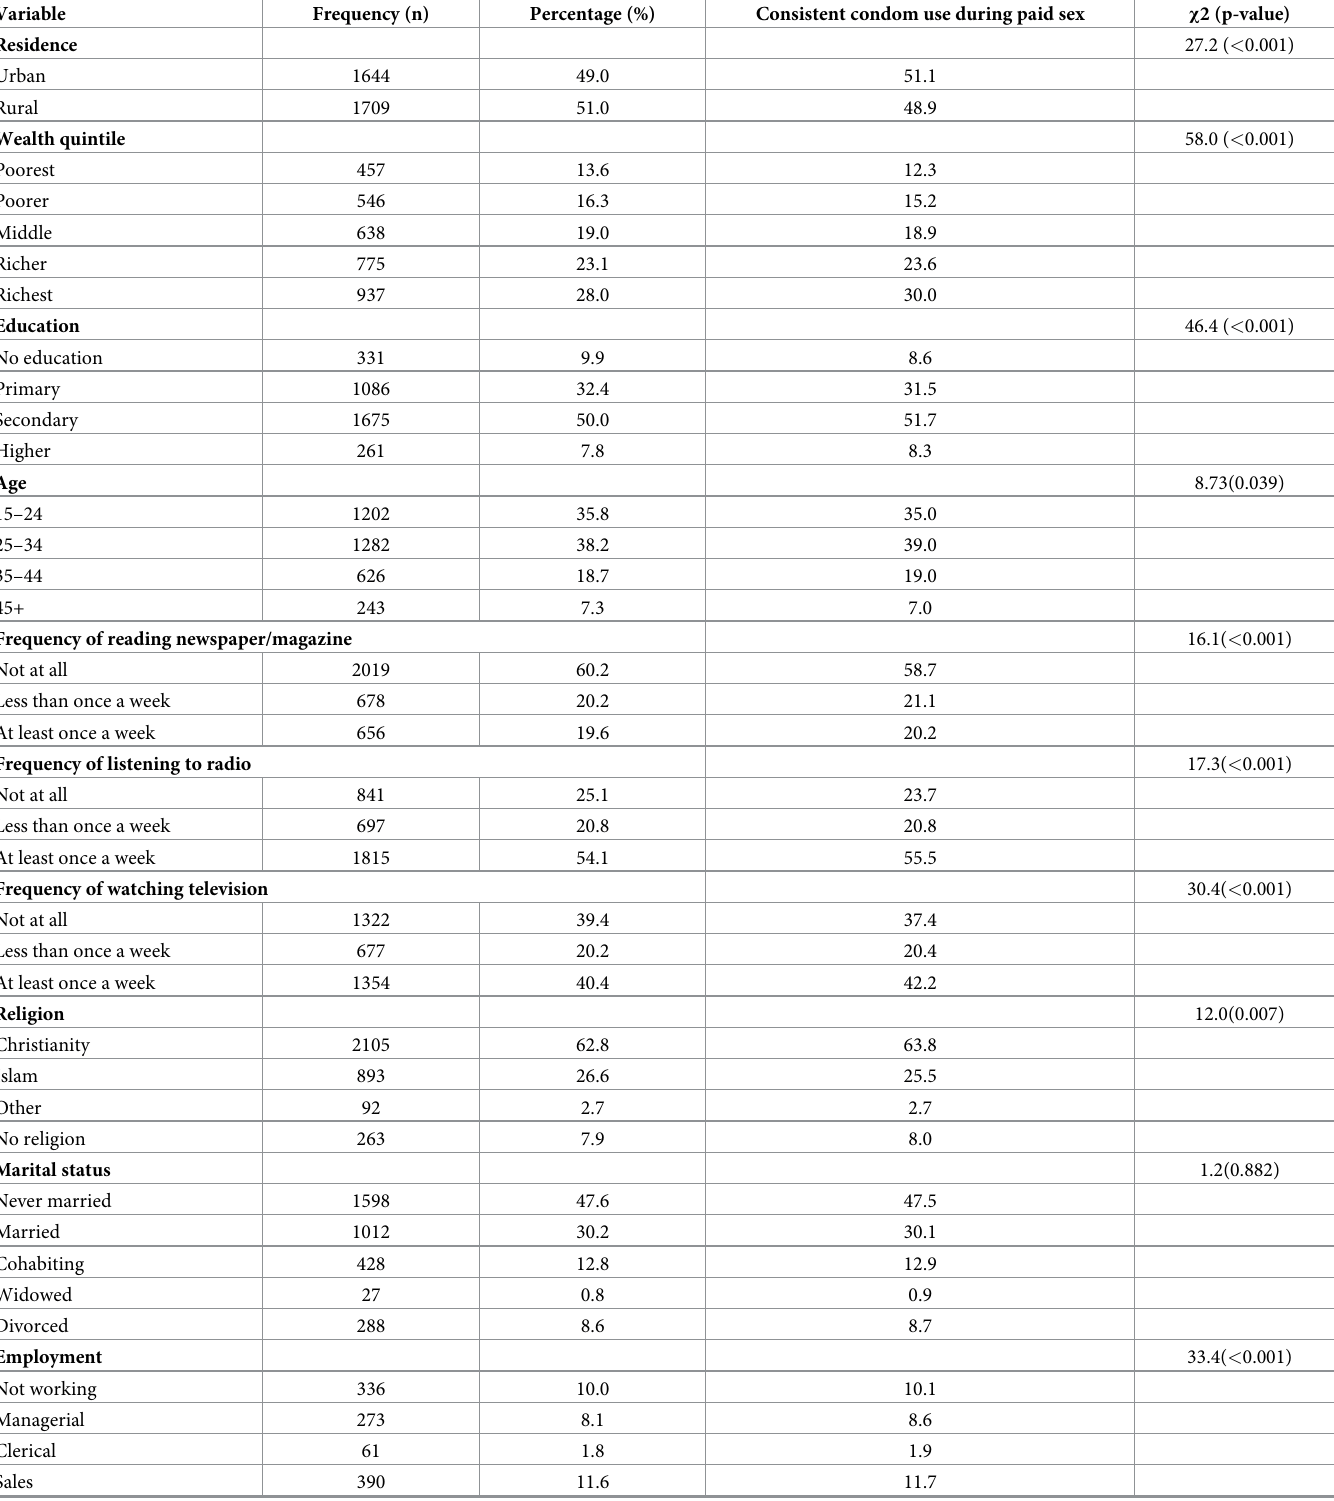
Table 1. Socio-demographic characteristics and consistent condom use during paid sex among men in SSA